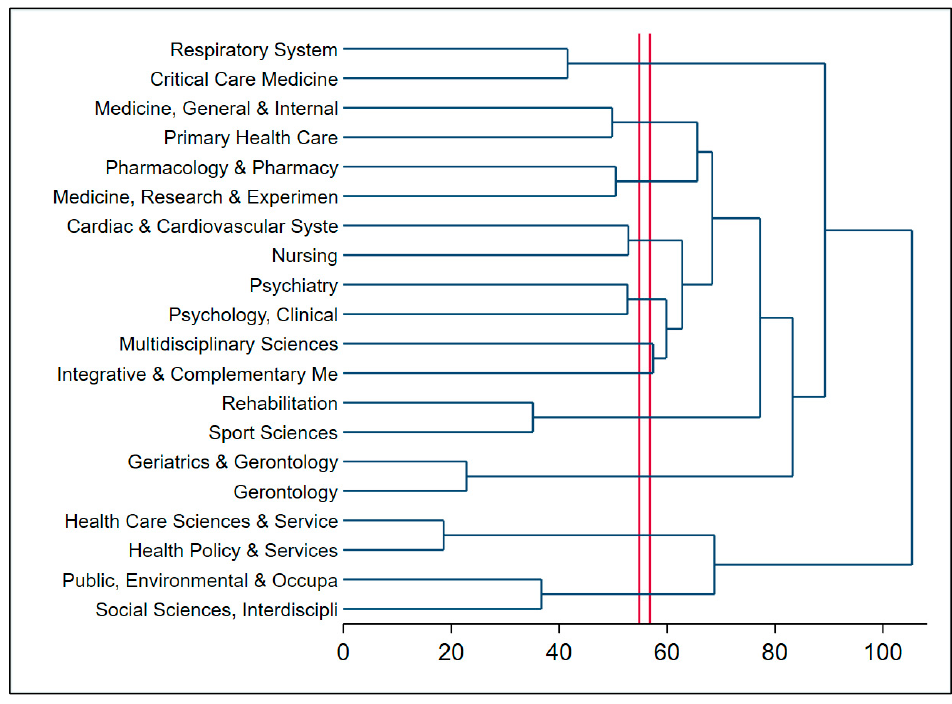
Figure 4. Dendrogram of coincidence of research areas